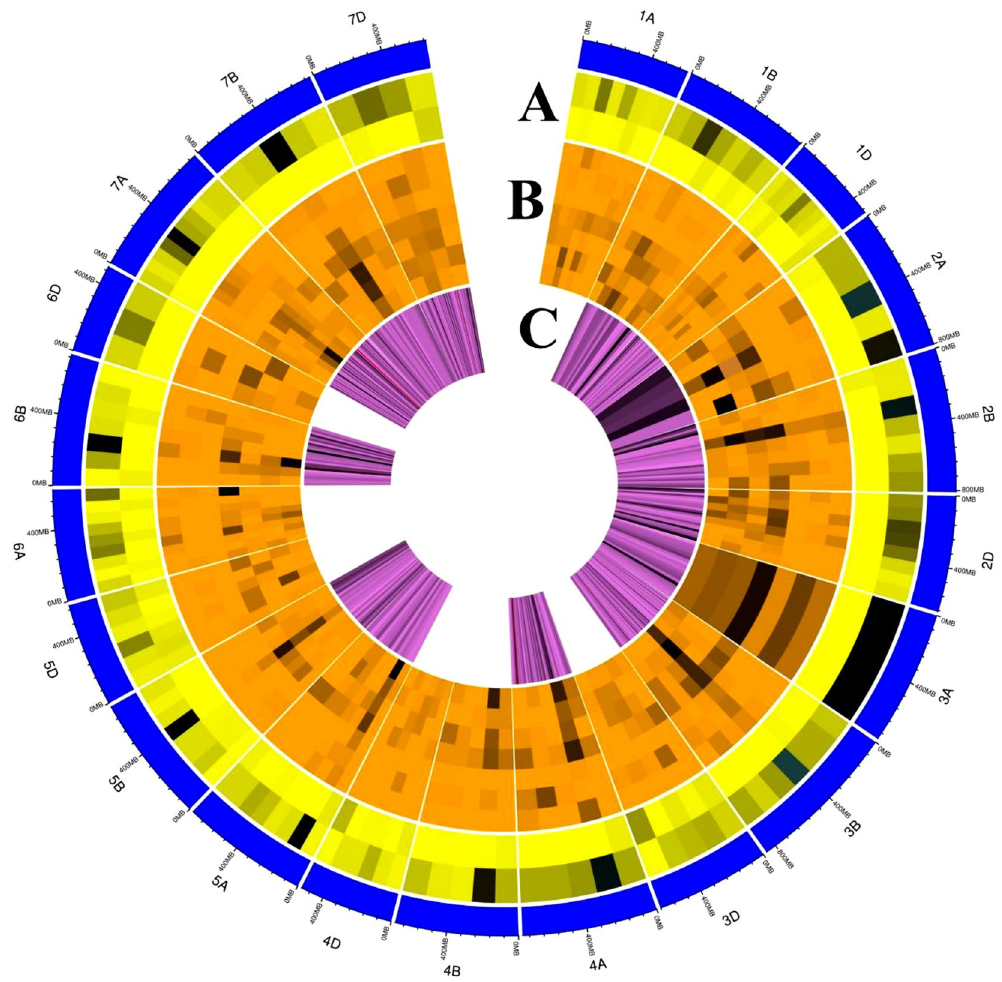
Figure 7. Circular diagram depicting the salient characteristics of QTLs and MQTLs. Circle A represents the number of QTLs involved in individual MQTLs. Circle B represents the number of QTLs for each stress in individual MQTLs and number of traits associated with individual MQTLs. Circle C represents the densities of the genes in different MQTL regions. The physical maps of wheat chromosomes are represented by the outer